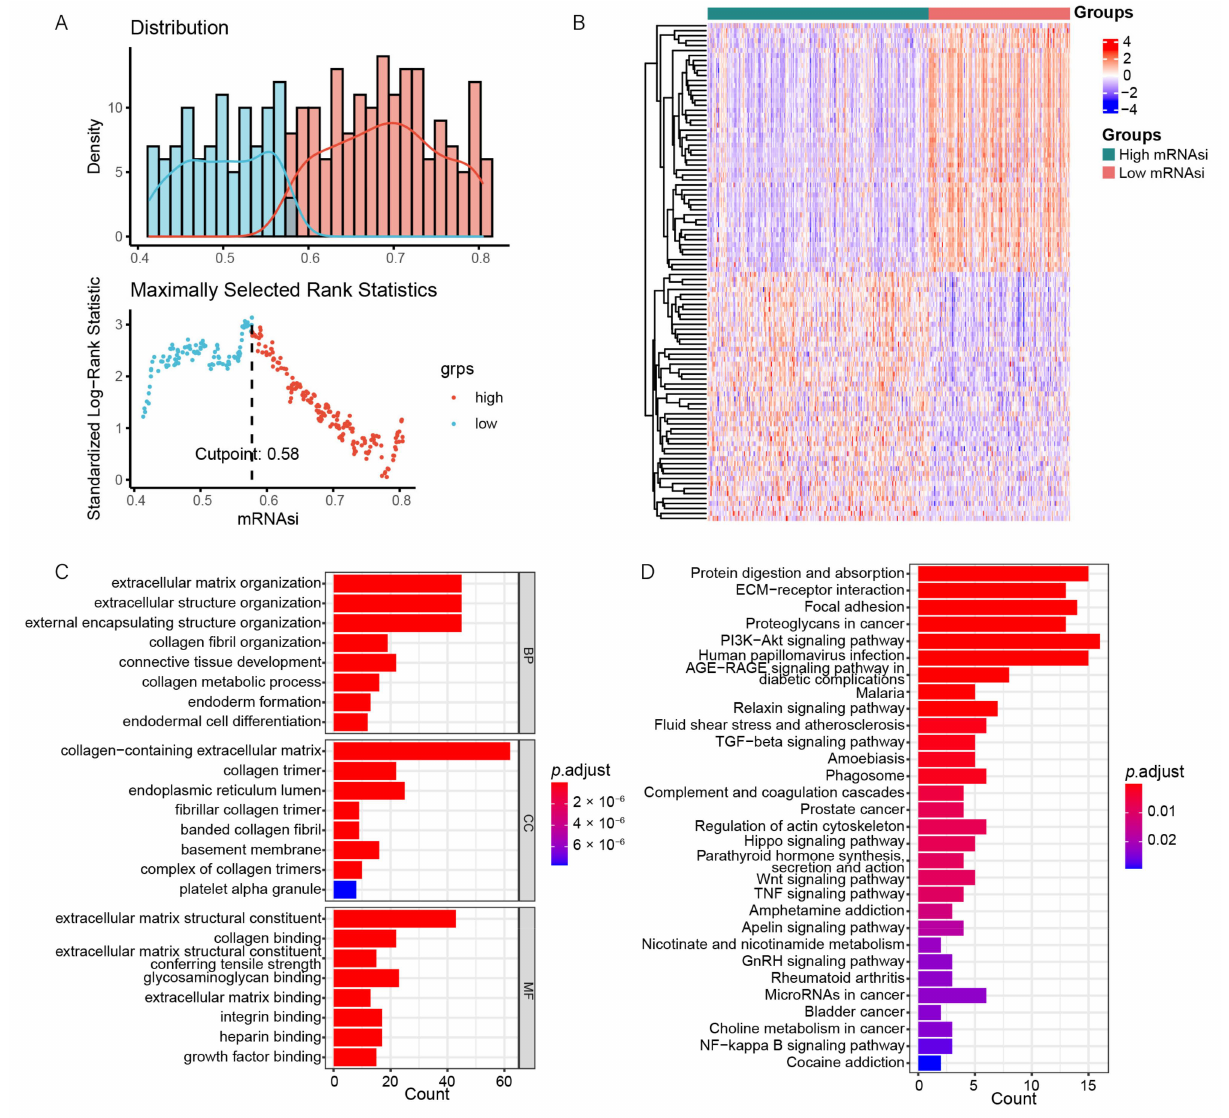
Figure 3. Differential expression analysis and functional enrichment analysis. ( A ) We determined 0.58 as the optimal grouping value. ( B ) The heatmap reflects the expression levels of DEGs. ( C ) The GO functional annotation analysis. ( D ) The KEGG pathway enrichment